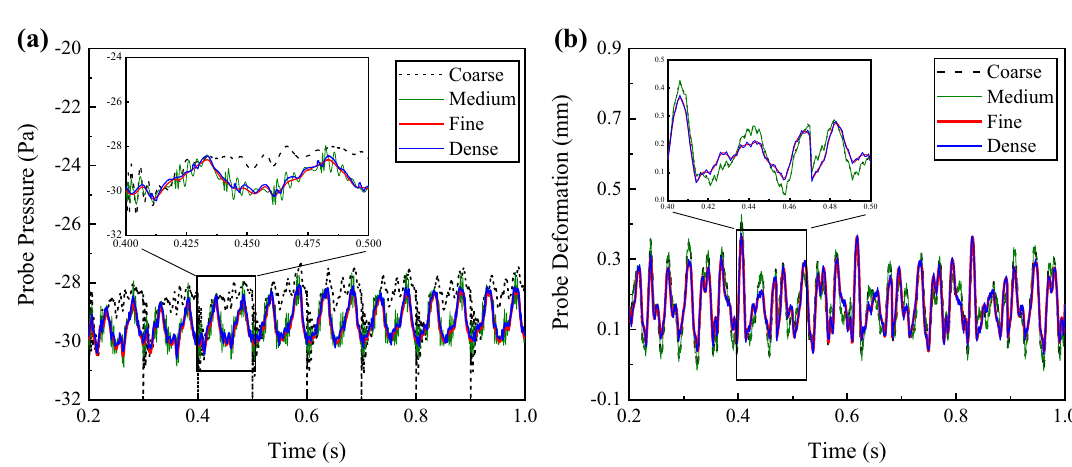
Figure 8. Grids independent study for the instantaneous ( a ) wall pressure and ( b ) probe displacement of structure, respectively. The grid number of the coarse, medium, fine, and dense fluid meshes are 1.31, 2.73, 4.53, and 11.16 million. The grid number of the structure meshes are 0.04, 0.12, 0.2, and 0.46